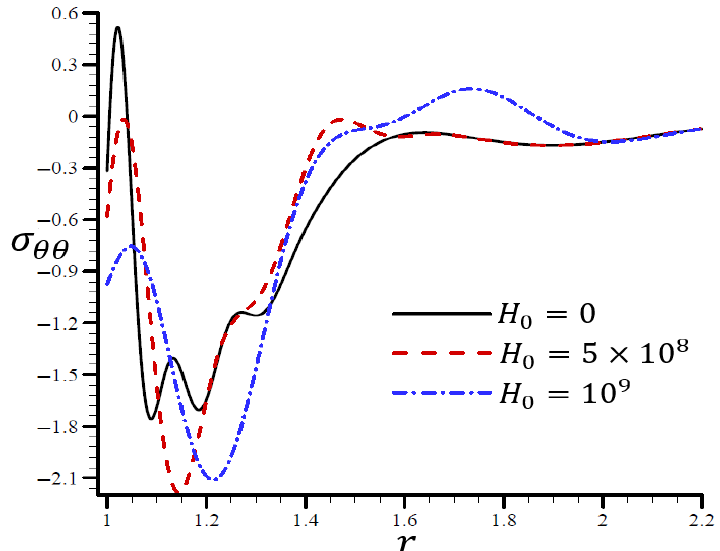
Figure 16. The influence of 𝐻 0 on circumferential stress 𝜎 𝜃𝜃 through the radial direction of the spherical hole using the RTPL model.